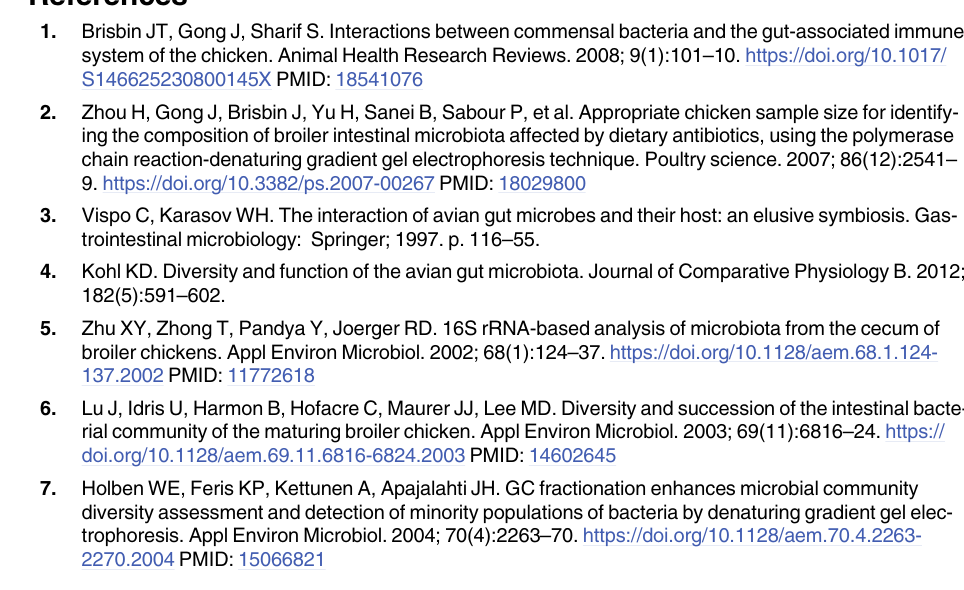
S1 Table. Percentile abundance between